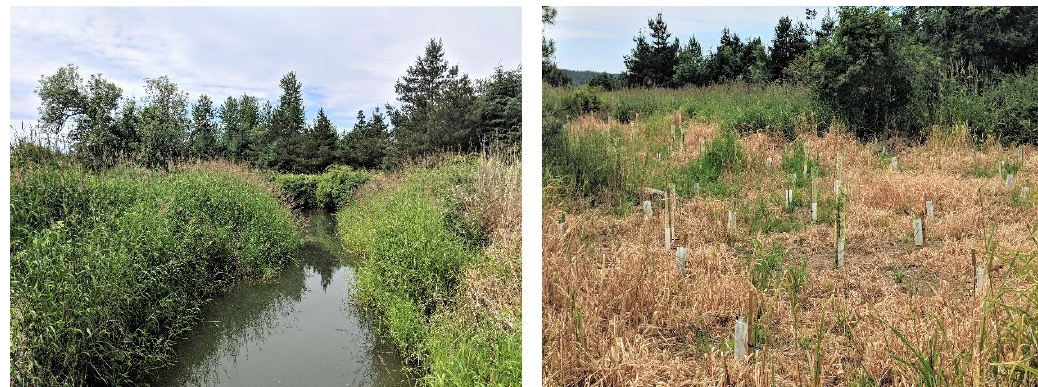
Figure 6. Lincoln Creek ( left ), part of the Chehalis Basin, runs through an agricultural property, and floods the fields during the winter. The Conservation Reserve Easement Program (CREP) offers financial assistance to landowners for the planting of native riparian buffers, like this planting near Lincoln Creek ( right ).